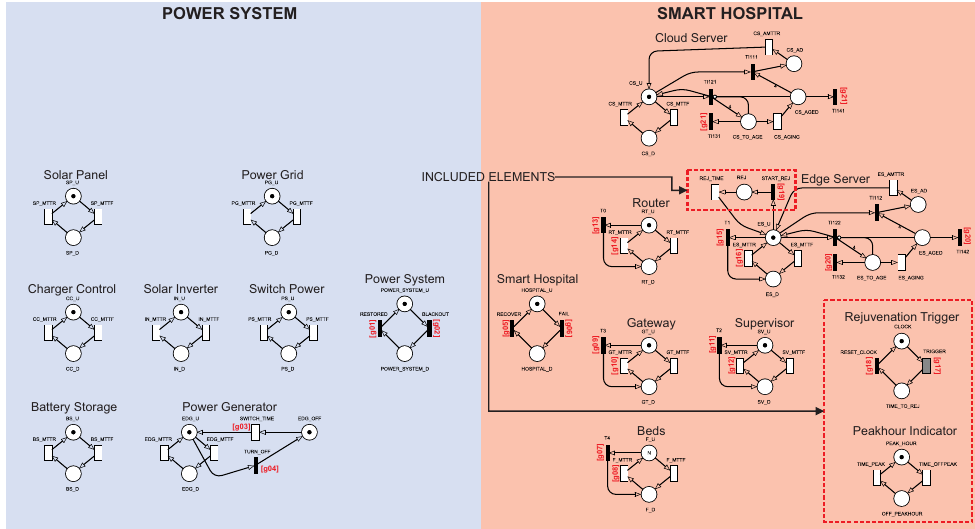
Figure 7. SPN model C for availability.